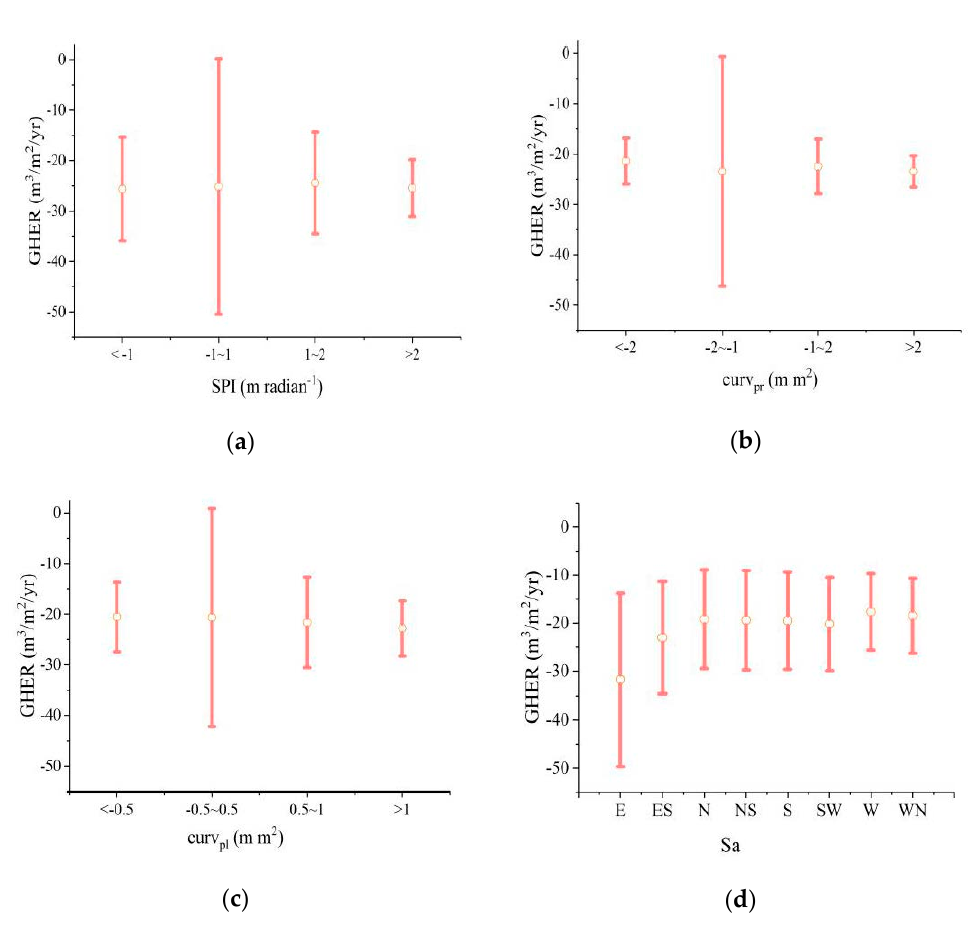
Figure 16. Mean ± standard error of the gully head erosion rate (GHER) as a function of ( a ) SPI, ( b ) Curv pr , ( c ) Curv pl , and ( d ) Sa.